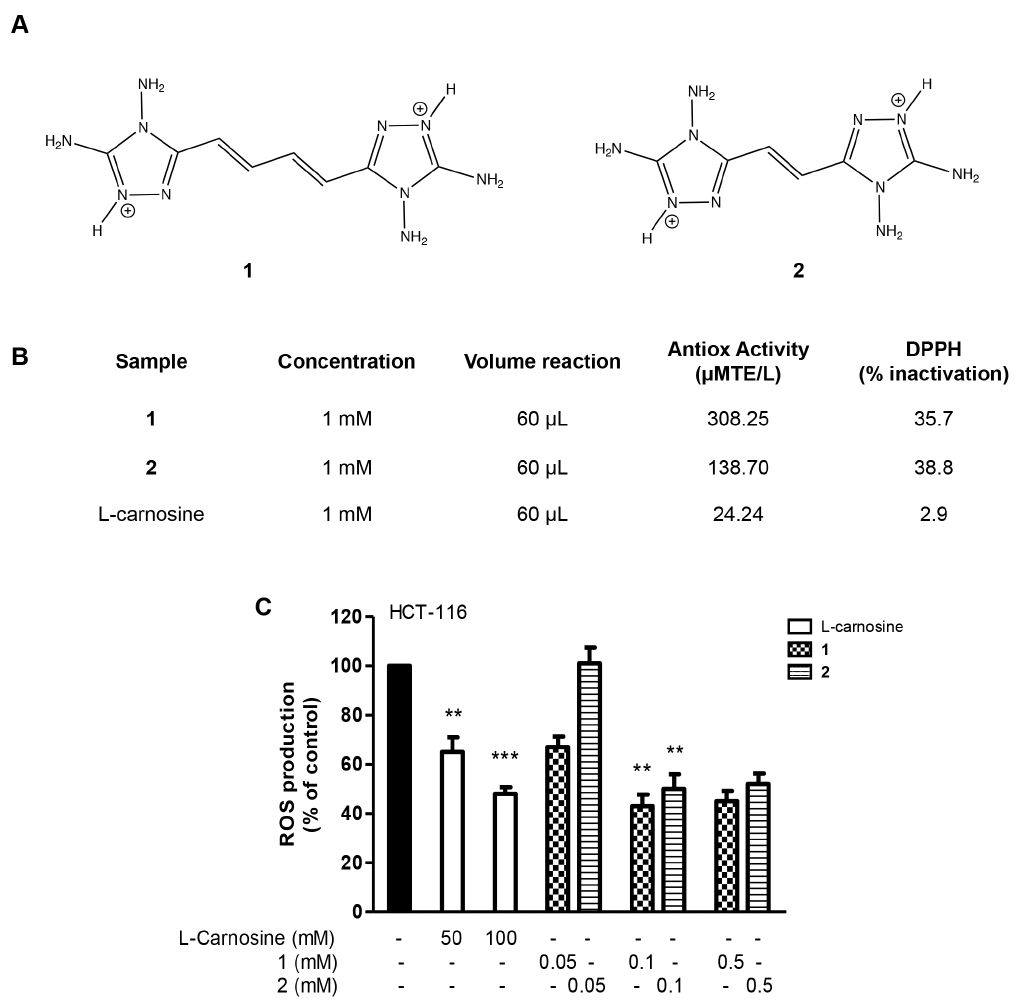
Figure 5. Compounds 1, 2 and L-carnosine strongly reduce the production of intracellular ROS. (A) Chemical structures of compounds 1 and 2 ; (B) Antioxidant activity of L-carnosine, 1 and 2 measured by the DPPH method as described in Section 1.2.4; (C) ROS production evaluated 24 h after the addition of L-carnosine, 1 and 2 in HCT-116 cells by the probe 2 9 ,7 9 -dichlorofluorescein-diacetate (H2DCF-DA). All values represent the mean 6 SDs of three independent experiments and are expressed as a percentage compared to 100% of control cells. The differences were considered significant at **p , 0.001, ***p , 0.0001.